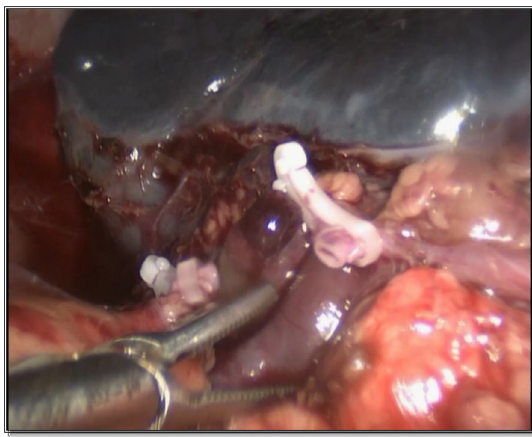
Fig. 7 The vein was dissected between 2 clips proximal and 1 clip distal (hilum after complete devascularization of